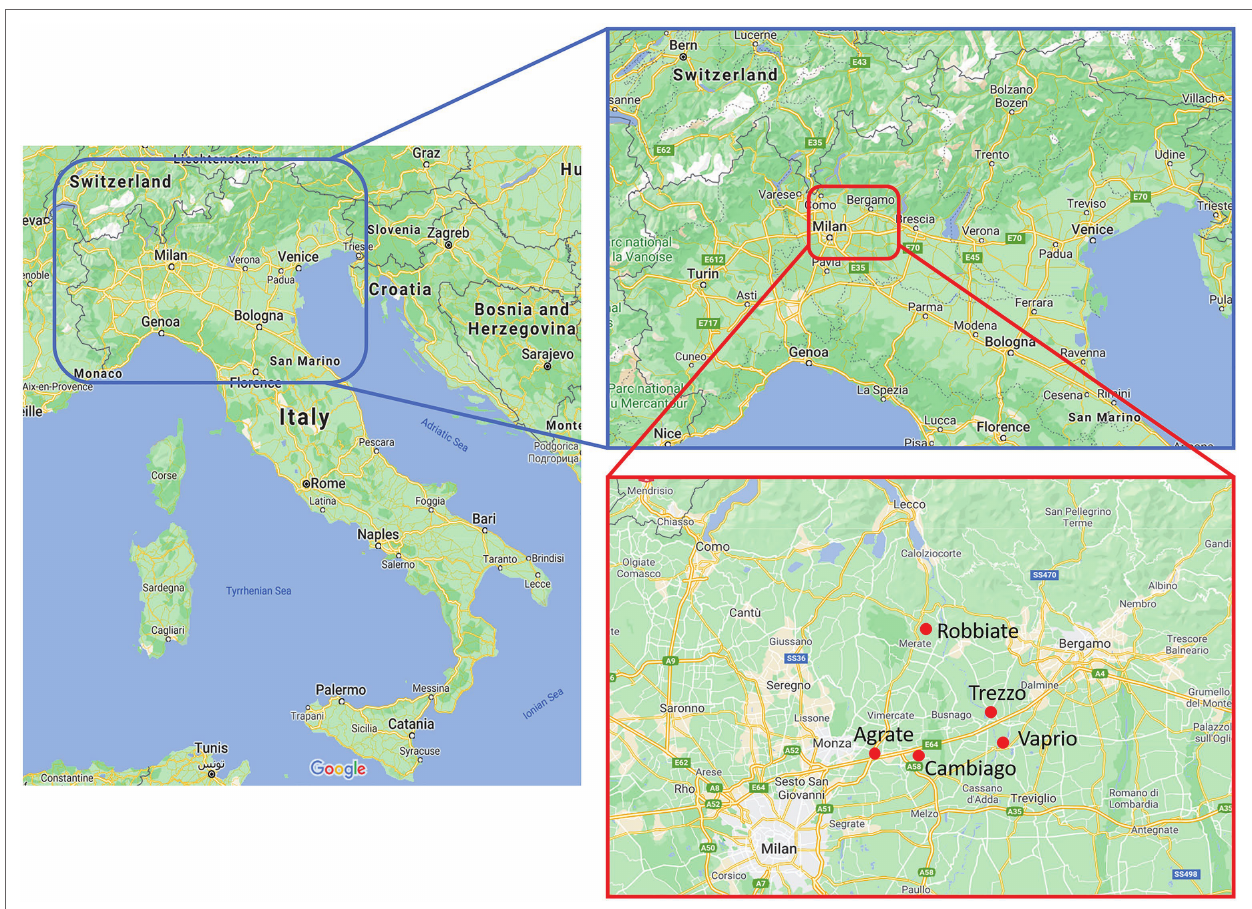
FIGURE 1 | Location in Northern Italy of the Early Childhood Services located in Agrate, Cambiago, Vaprio, Trezzo, and